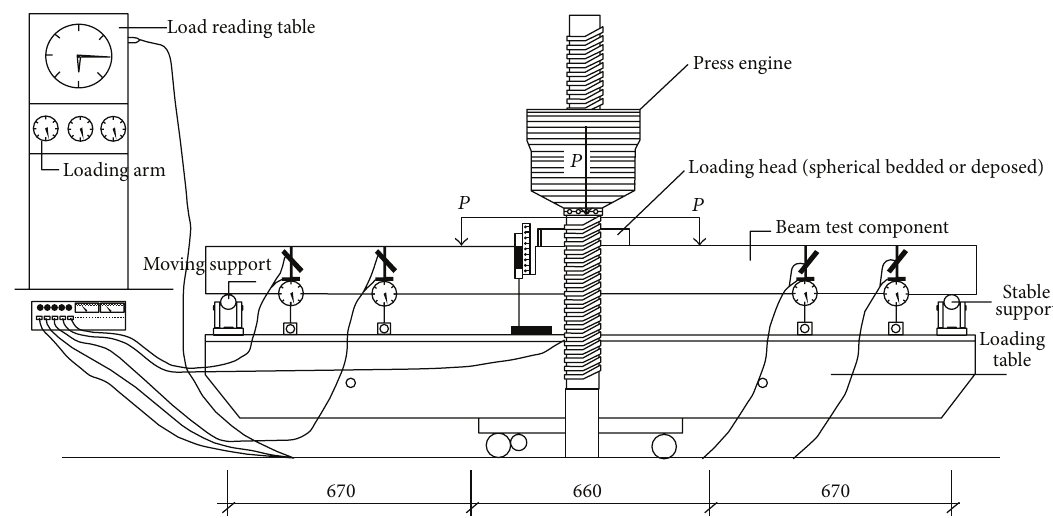
Figure 5: Scheme of the loading mechanism.